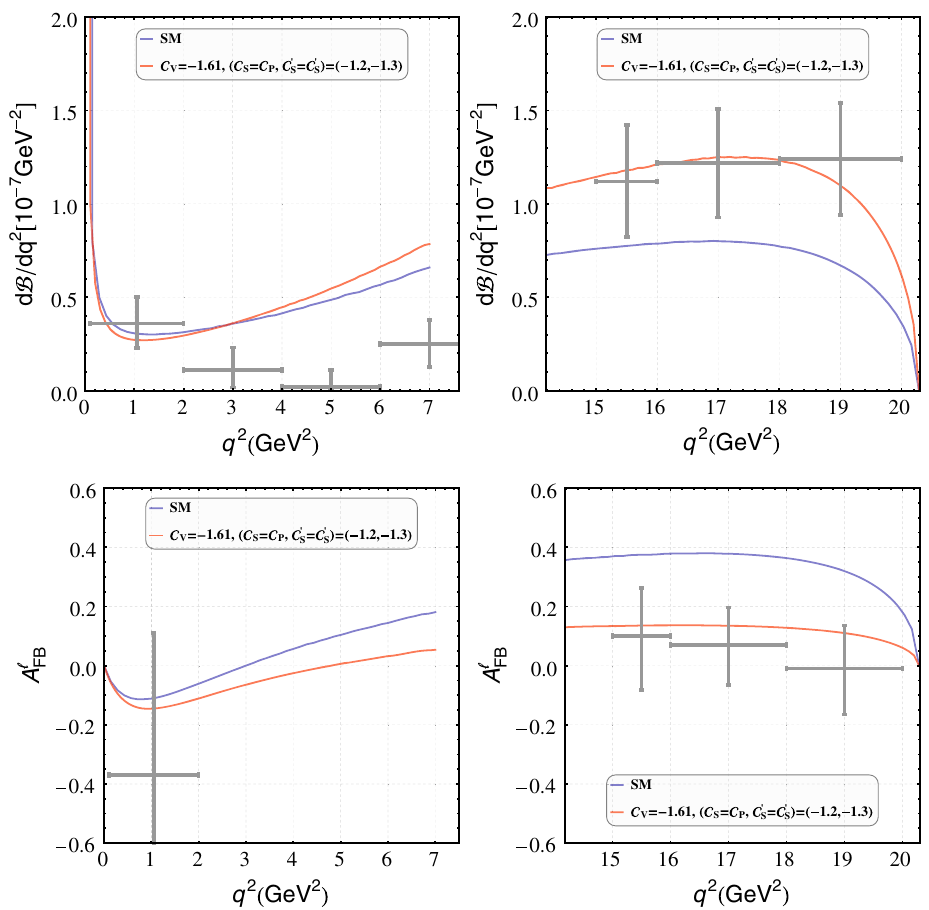
Fig. 5 The (cid:2) b → (cid:2)(cid:3)(cid:3) observables in the SM (blue) and in the simultaneous presence of VA and SP couplings(red). The points shown by cross marks indicate LHCb data